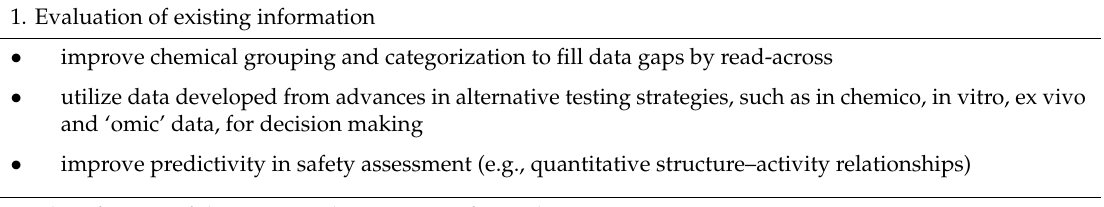
Table 2. Potential applications and benefits of the AOP framework in chemical risk